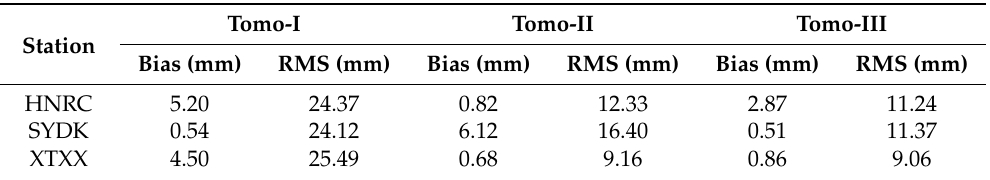
Table 1. Biases and RMS errors of the di ff erences between GPS-estimated SWDs and tomographic SWDs using schemes Tomo-I, Tomo-II, and